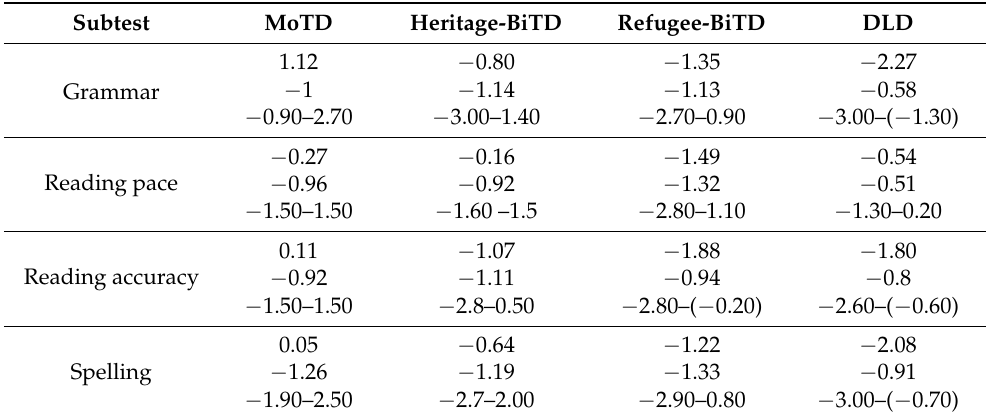
Table A1. Group performances on BUEGA subtests in z -values (Mean, SD , range) 1 .